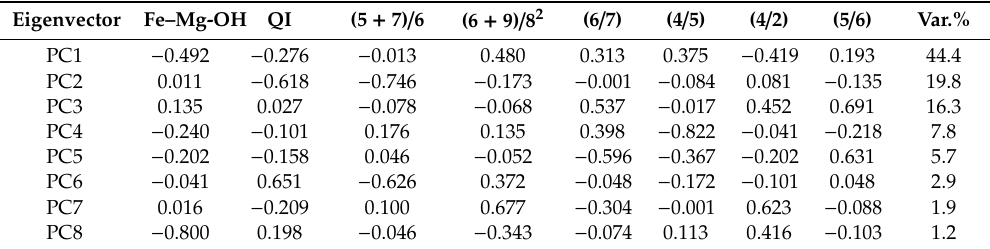
Table 2. Eigenvector loadings of principal component analysis (PCA) for OLI-band ratios and ASTER − RBD mineralogical indices. PC—principal component, QI—quartz index, Var.%—variation in